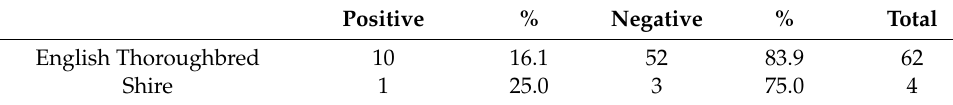
Table 5. EcPV9 genoprevalence on the basis of mares breed.